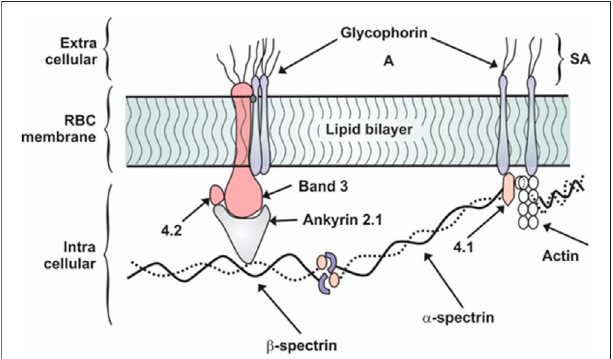
FIGURE 1 | Schematic representation of RBC membrane showing protein orientation. Adapted from (Desouky 2009). SA, sialic